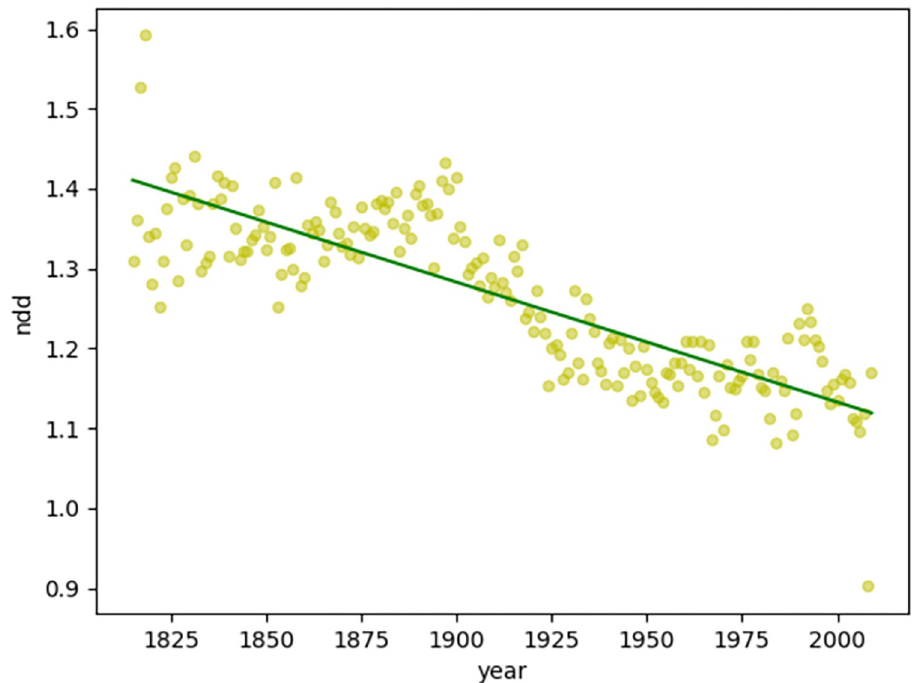
Fig 3. Diachronic linear distribution of NDD for magazine